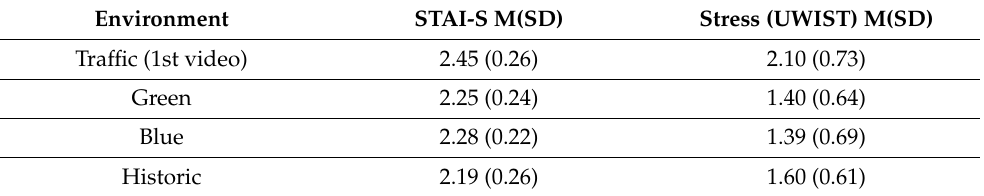
Table 2. Subjective outcome measures (STAI-S and UWIST) after exposure to each